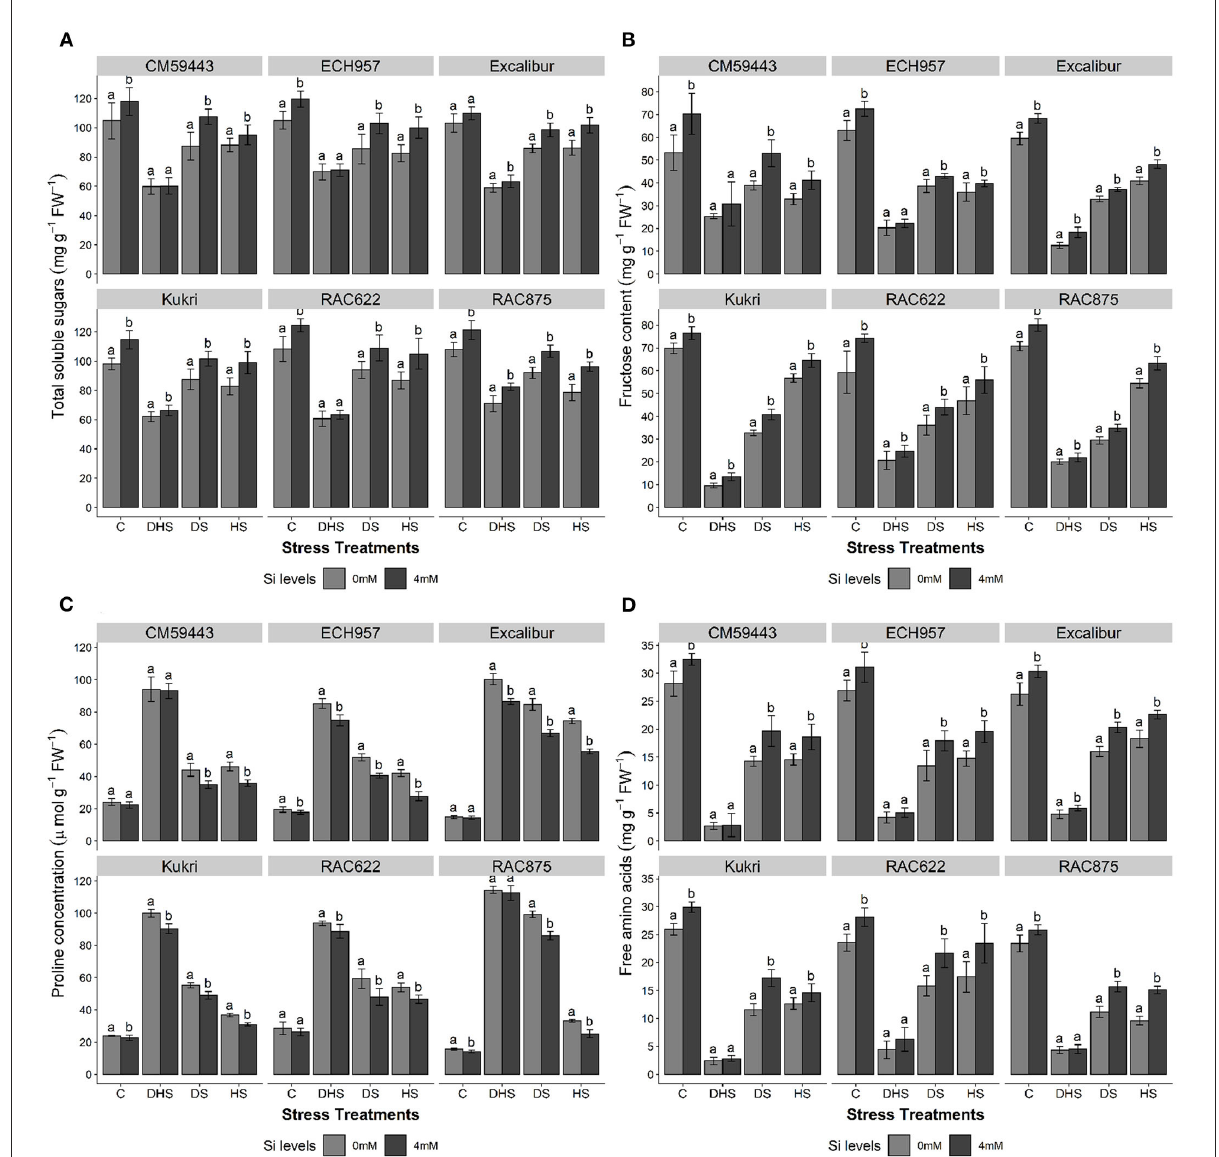
FIGURE4 (A–D) Effect of silicon on (A) total soluble sugars (TSS) (mg g − 1 FW), (B) fructose content (FC) (mg g − 1 FW), (C) proline concentration ( µ mol g − 1 FW), and (D) free amino acids (AA) (mg g − 1 FW) of six contrasting wheat cultivars under terminal DS, HS, and DHS in a controlled glasshouse conditions. Mean values are presented with ± SE, represented with error bars. Different letters denote statistical significance within each cultivar at p <